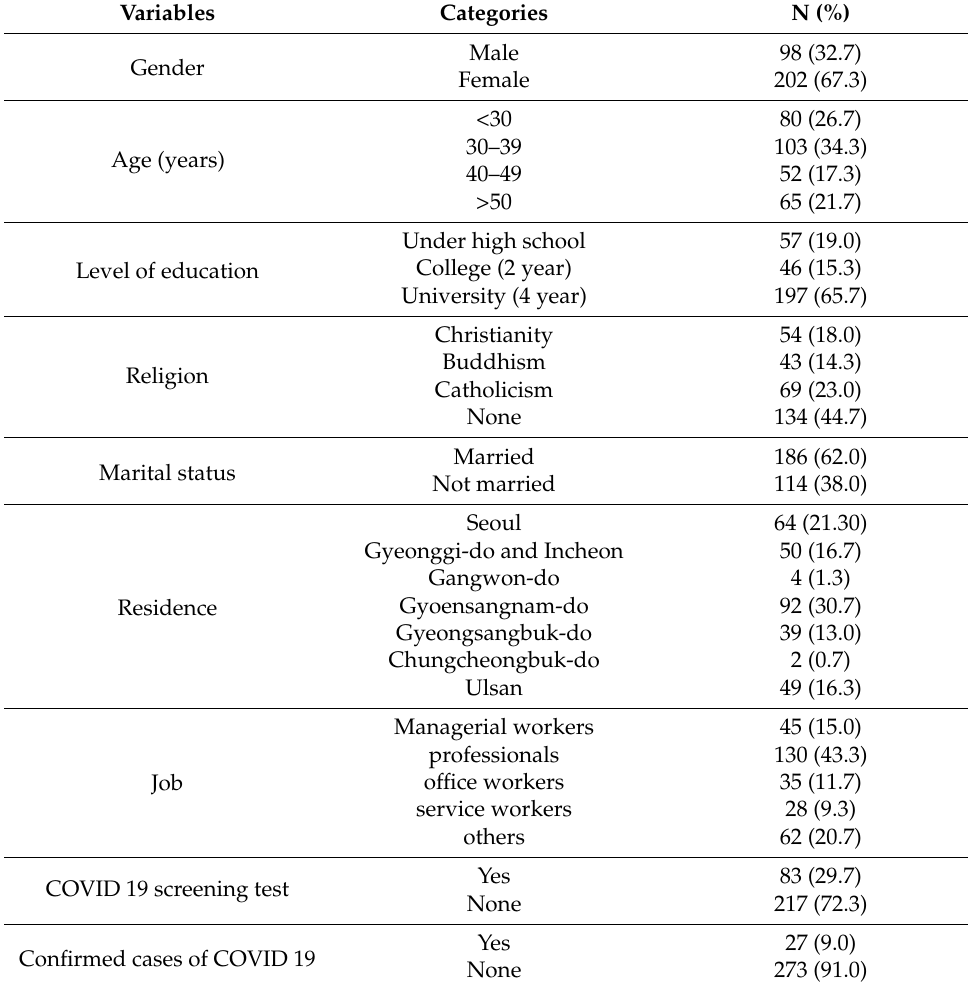
Table 1. Participants’ general